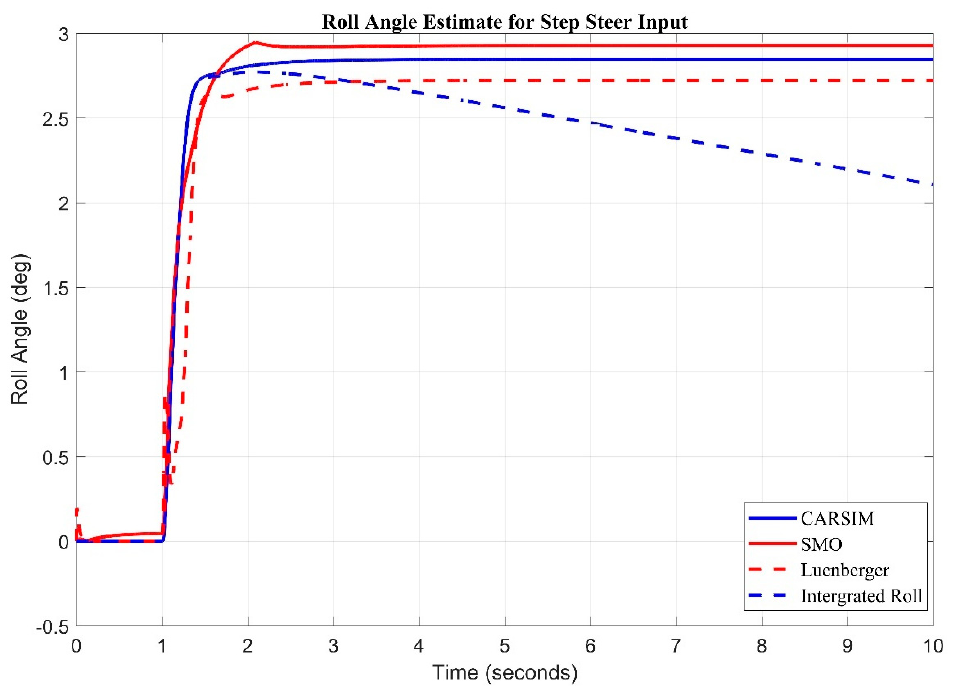
Figure 8. Observer results for step input estimate for roll angle .